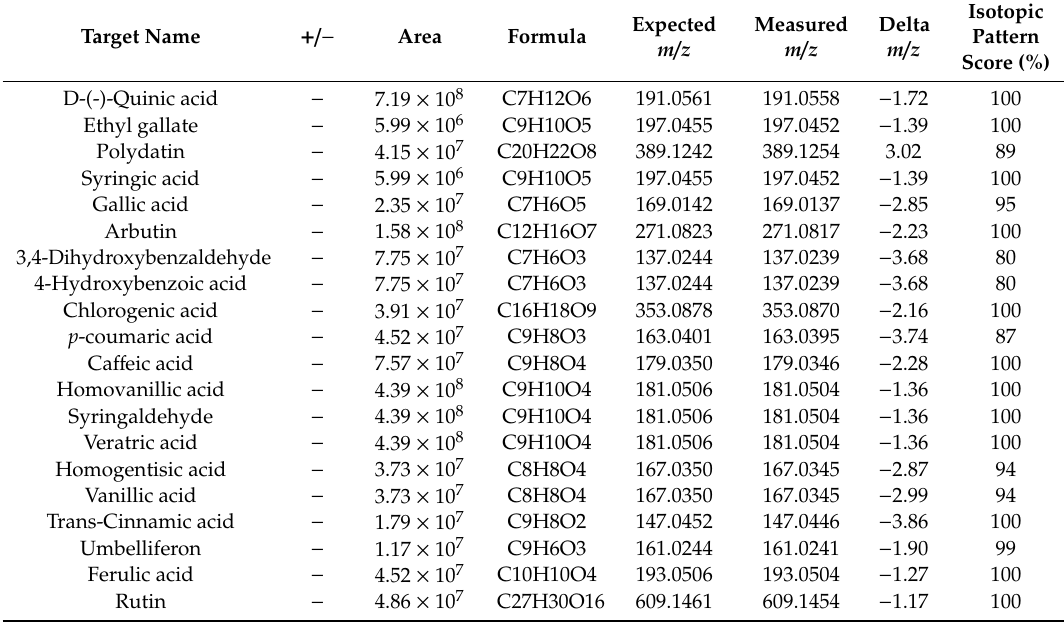
Figure 1. Ultra-high performance liquid chromatography-high-resolution mass spectrometry (UHPLC-HRMS) total ion chromatograms ( a ) and the extracted ion chromatograms for ferulic acid ( m / z 193.0506) ( b ) of the three selected sweet La Vera Protected Designation of Origin (PDO), Murcia PDO, and Czech Republic paprika samples. Table 1. TraceFinder TM polyphenolic profiling report obtained for a sweet La Vera PDO